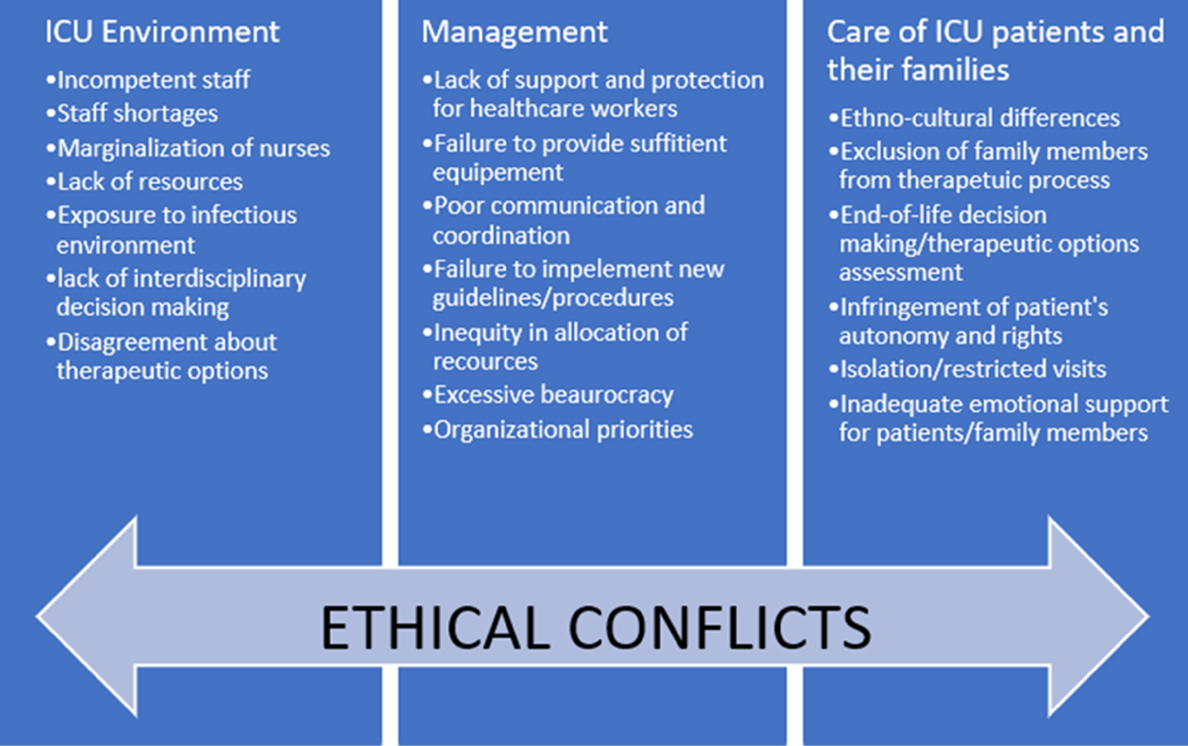
Figure 1. Summary of sources of conflict in the ICUs.